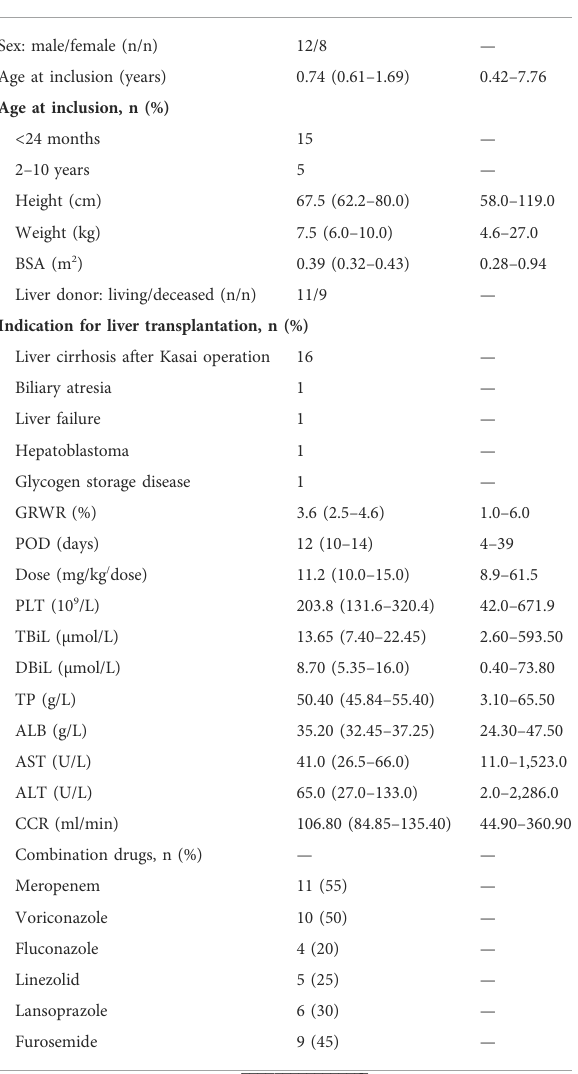
TABLE 1 Demographic characteristics and Laboratory test results of pediatric patients.